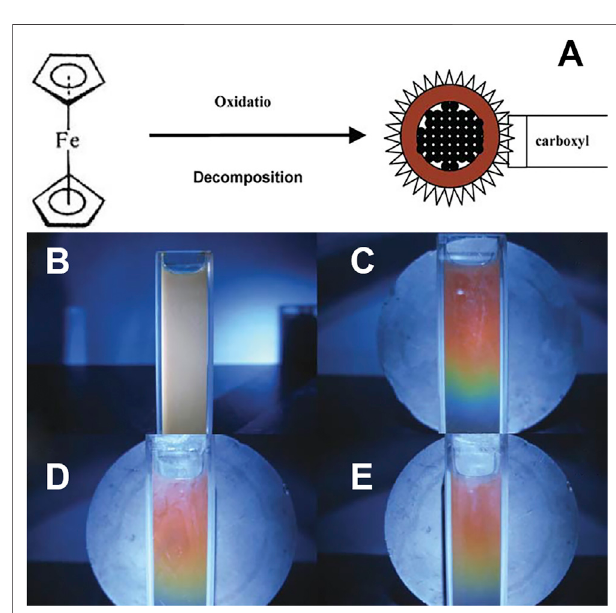
FIGURE 6 | (A) Schematic of synthesis of carboxyl-functionalized magnetite/carbon core/shell nanoparticles; Black dot represents magnetite nanocrystals; red ring symbolizes the carbon; (B) Re fl ection photographs of the CNPs solution without MF; and (C – E) Re fl ection photographs of the CNPs solution under an external MF (0.20 T) with different stored time: (B , C) 0 m; (D) 4 m; (E) 8 m. Reprinted with permission from Wang et al. (2010). Copyright © 2010 Royal Society of